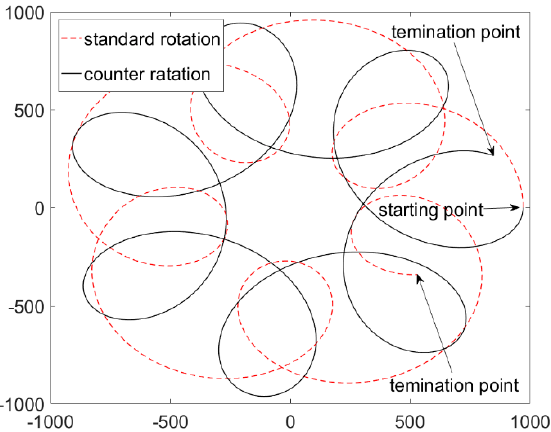
Figure 4. Paths in the standard and counter planetary rotation systems, as viewed from the top of the chamber.